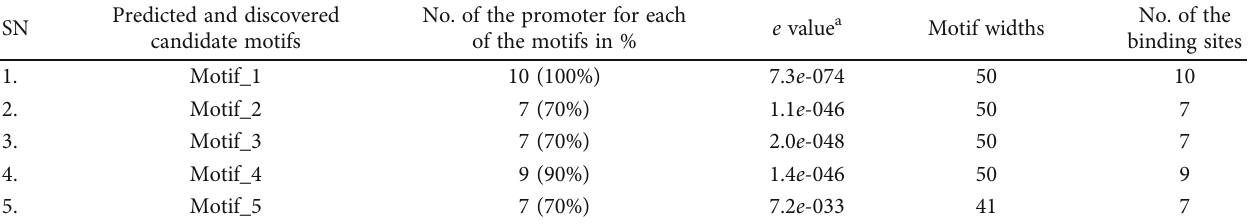
Table 3: List of predicted motifs and the number and proportion of promoter-containing motifs. SN